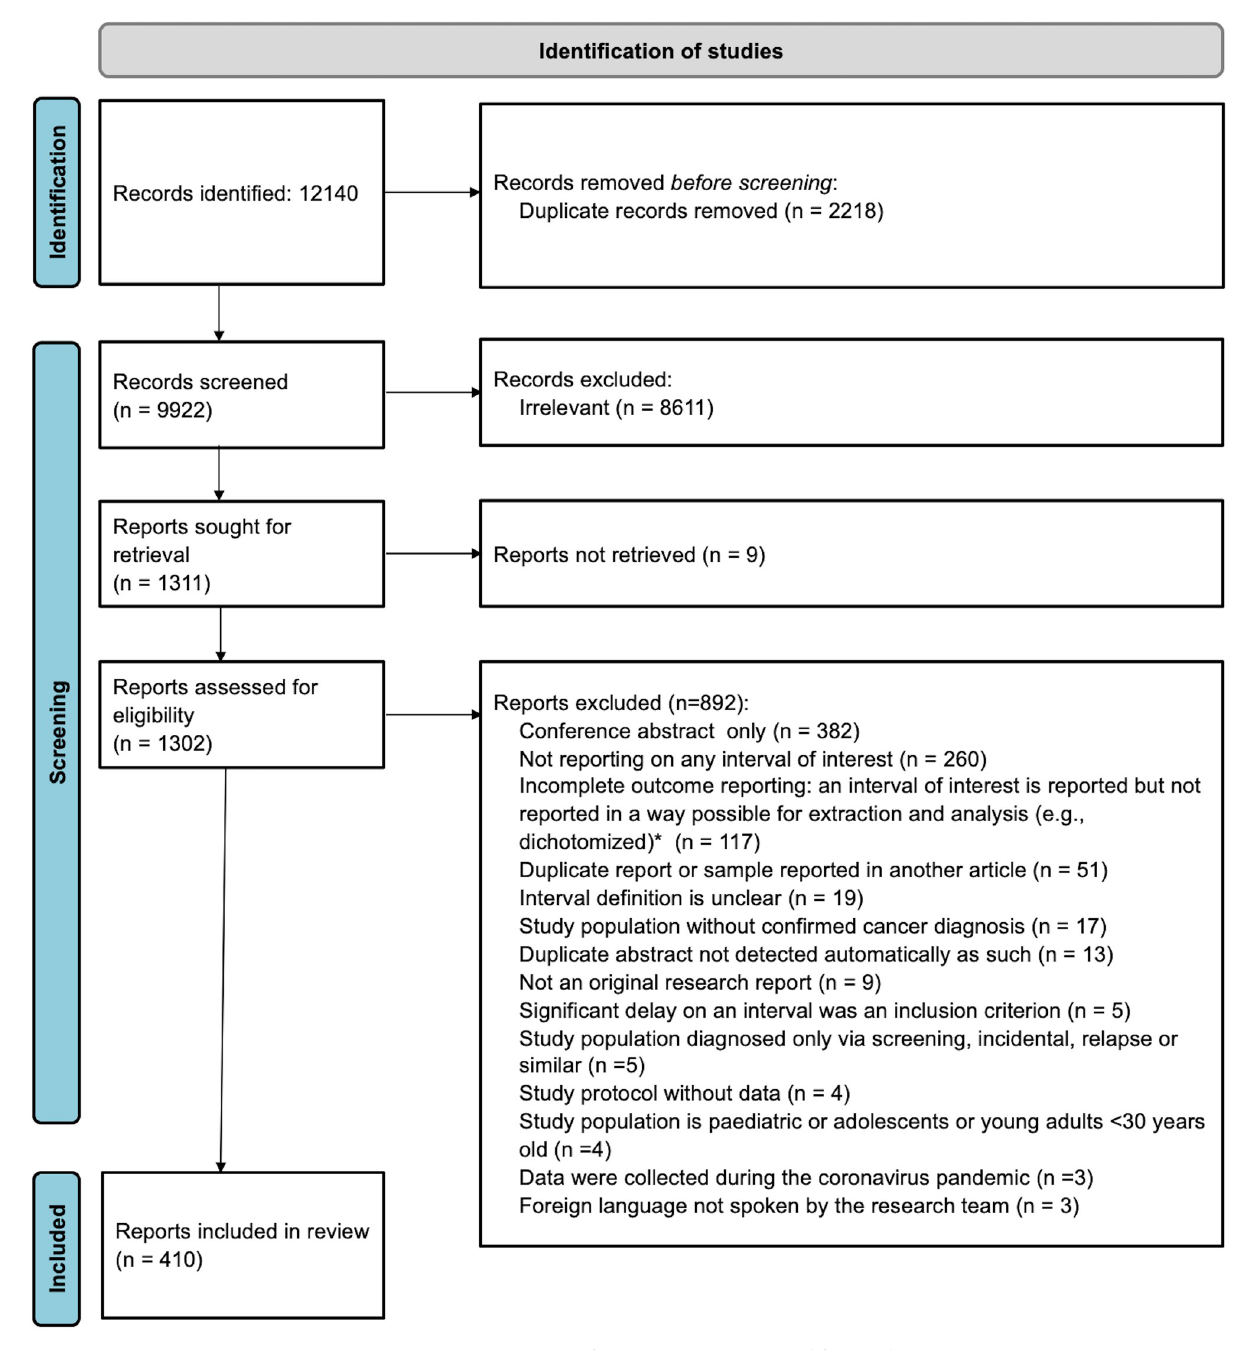
tries: 48 (12%) reporting data on upper-middle, 43 (10%) on lower-middle, and 24 (6%) on